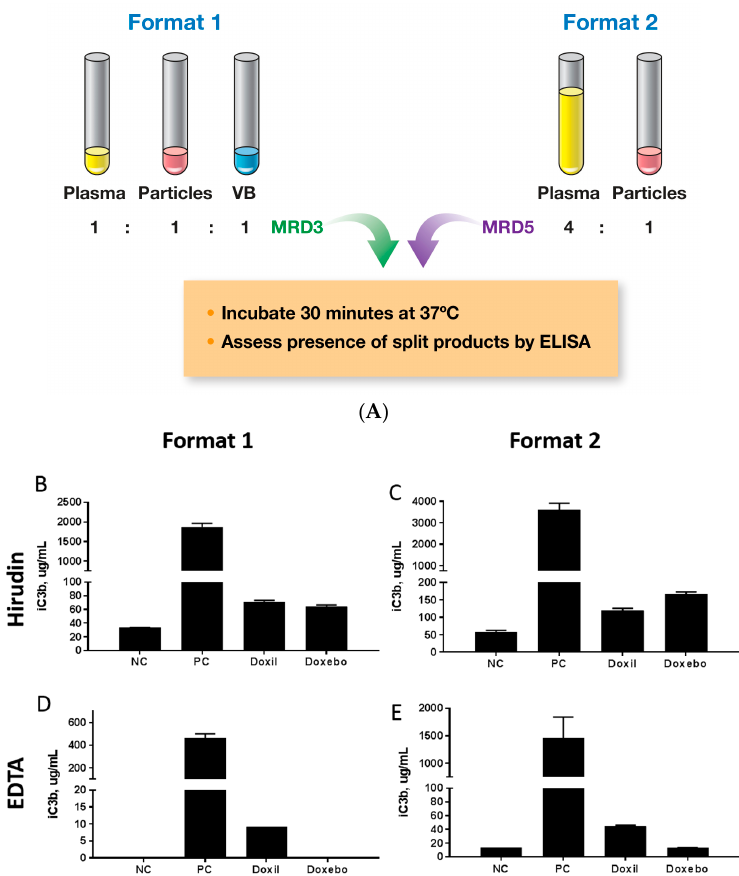
Figure 5. Complement activation. Various clinically relevant concentrations of Doxil and Doxebo were tested in vitro to estimate their effects on the complement system. PBS was used as the negative control (NC). Cobra venom factor (CVF) was used as the positive control (PC). Three independent samples were prepared for each concentration and analyzed in duplicate (%CV < 20). Particle concentration was 0.67 mg/mL of doxorubicin or equivalent for Doxil or Doxebo, respectively. Shown is the mean response ( n = 3) ± SD. ( A ) Schematic of two assay formats used in this experiment; The results of the assay format 1 using hirudin and EDTA anticoagulants ( B , D , respectively); The results of the assay format 2 using hirudin- and EDTA-anticoagulants ( C , E , respectively). BLOQ = below limit of quantification; VB = veronal buffer; MRD = minimum required dilution.